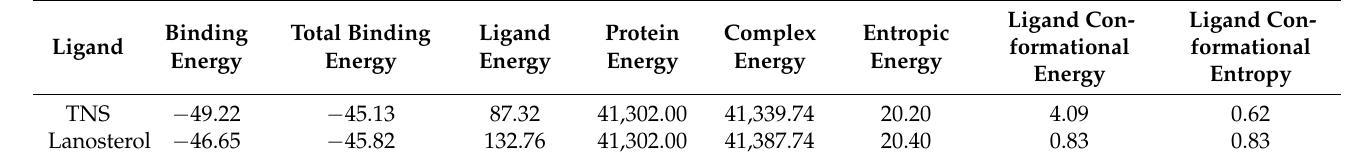
Table 2. Binding energy calculation of TNS- C. auris 14- α -demethylase enzyme complex vs. lanosterol − C. auris 14- α -demethylase enzyme